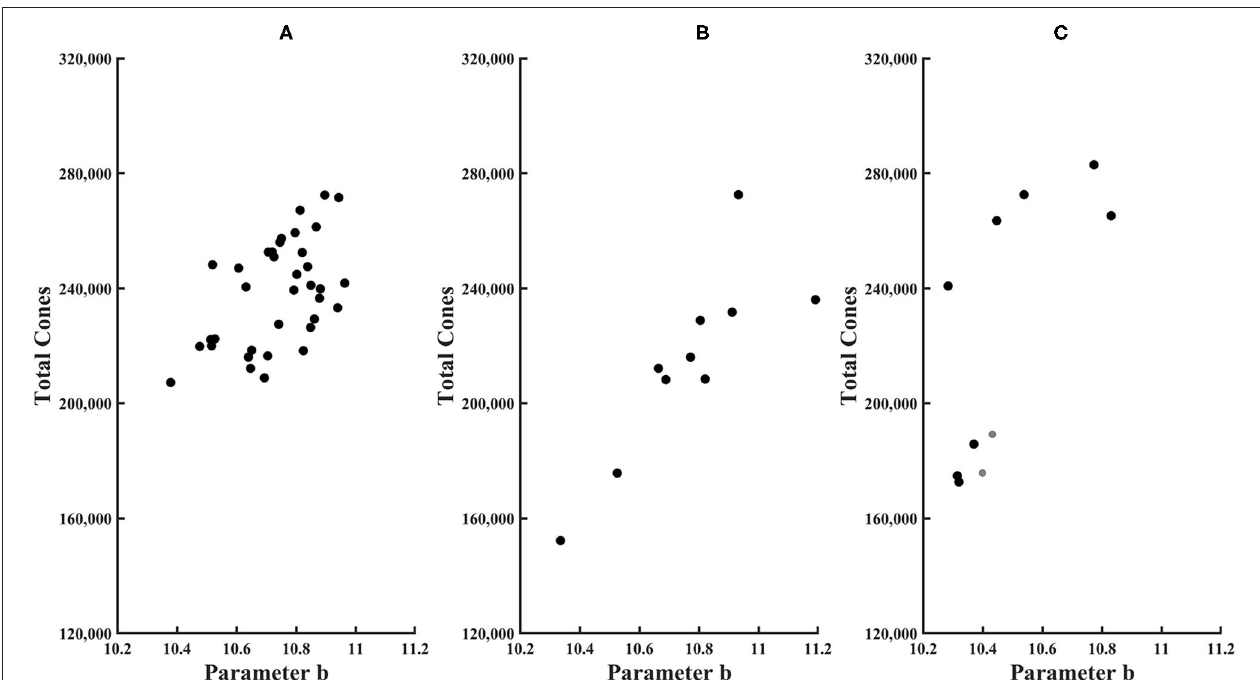
FIGURE 6 | Total cones plotted as a function of parameter b of the exponential model for (A) younger control subjects, (B) older control subjects, and (C) diabetic subjects. Younger subjects have smaller